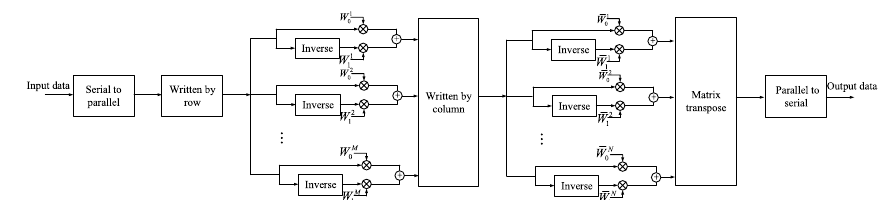
Fig. 2 Schematic of the proposed